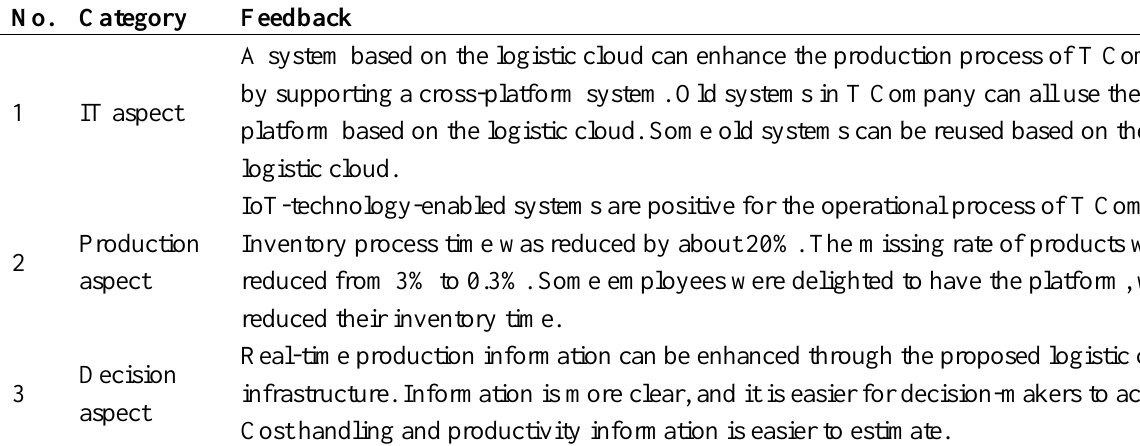
Table 9. Feedback collected from T